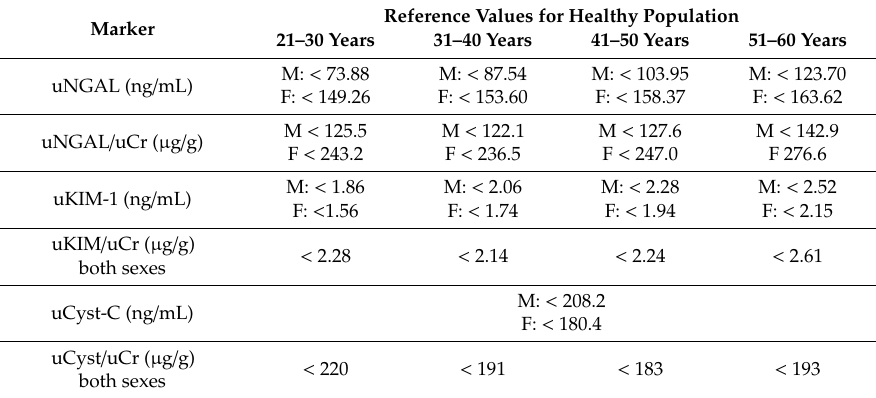
Table 1. Reference values for urinary NGAL, KIM and Cyst-C